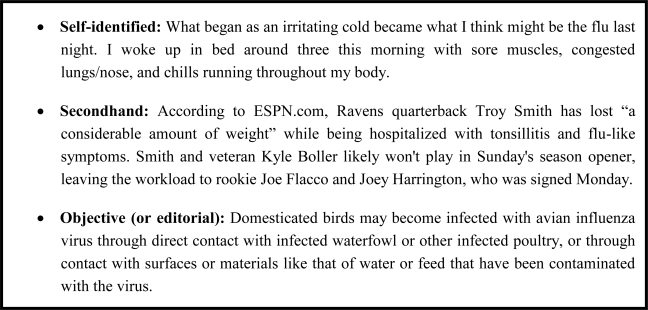
Three perspective blog posts that mention influenza: self-identification, secondhand, and objective/editorial.